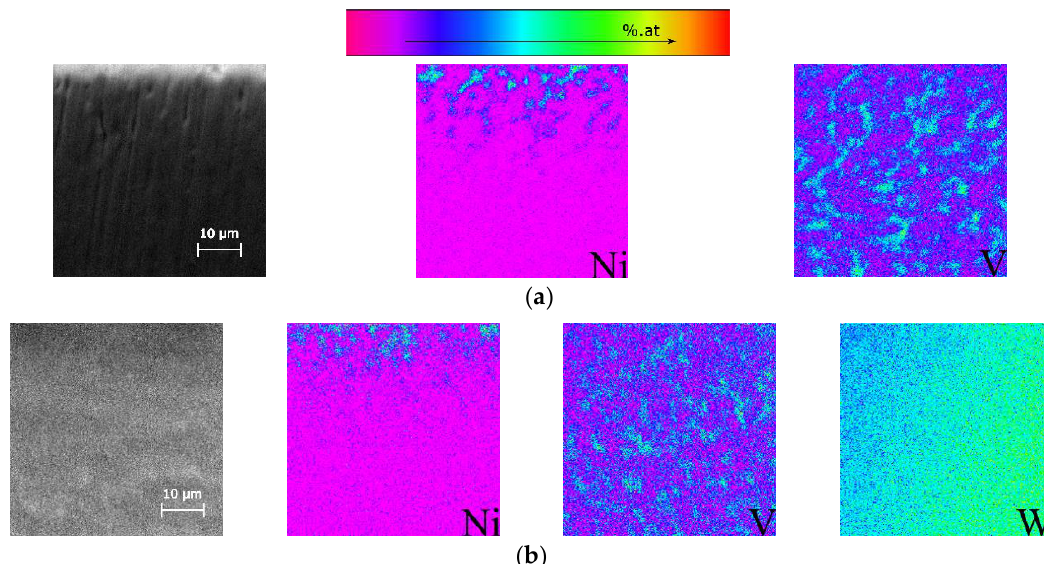
( b ) Figure 4. Cross-section SEM BSE images of Ni/Ti multilayer thin films with 12 nm period ( a ) without or ( b ) with W interlayer after HT at 850 °C. ( a ) ( b ) Figure 5. Cross-section SEM BSE images of Ni/Ti multilayer thin films with 25 nm period ( a ) without or ( b ) with W interlayer after HT at 900 °C. In order to analyze the diffusion phenomena in detail, cross- sections of the heat treated films were prepared and elemental (V, Ni and W) distributions over areas with 50 × 50 µm 2 were carried out by EPMA (Figures 6 and 7). The cross-sections were analyzed starting from the thin film/substrate interface to the Ti-6Al-4V bulk material, to avoid the steep Ni increase due to the film. In Figures 6 and 7, for each map the color scale is independent (from low concentration purple to high